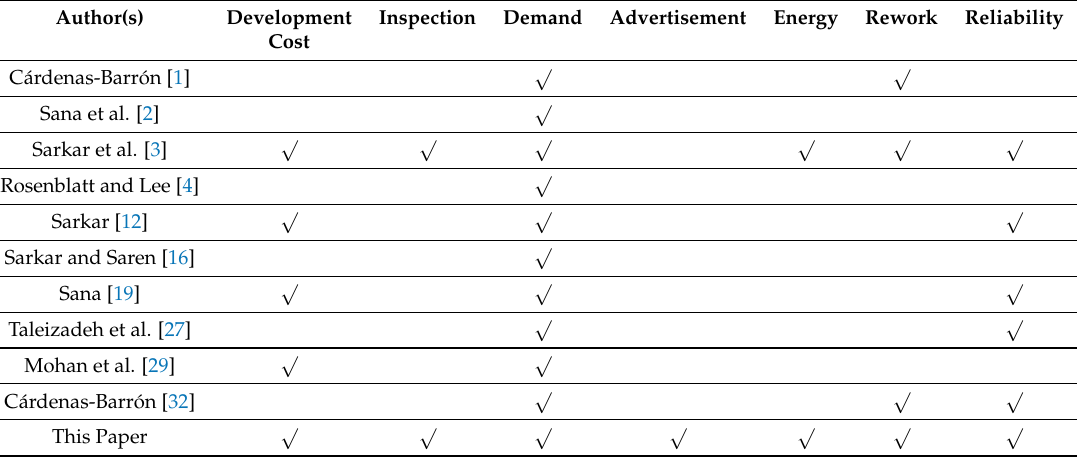
Table 1. Author(s) contribution